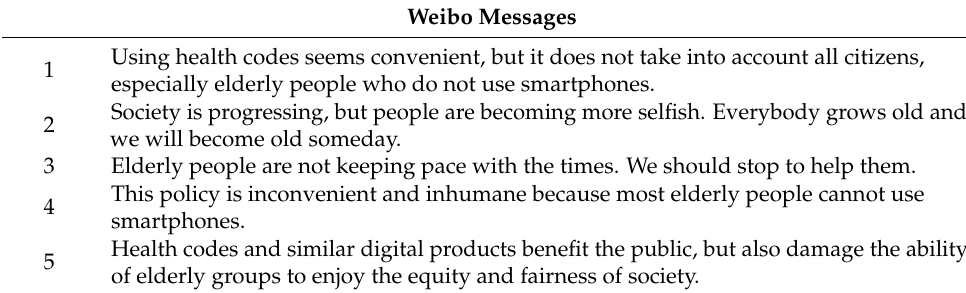
Table 3. Example messages regarding Topic 3.